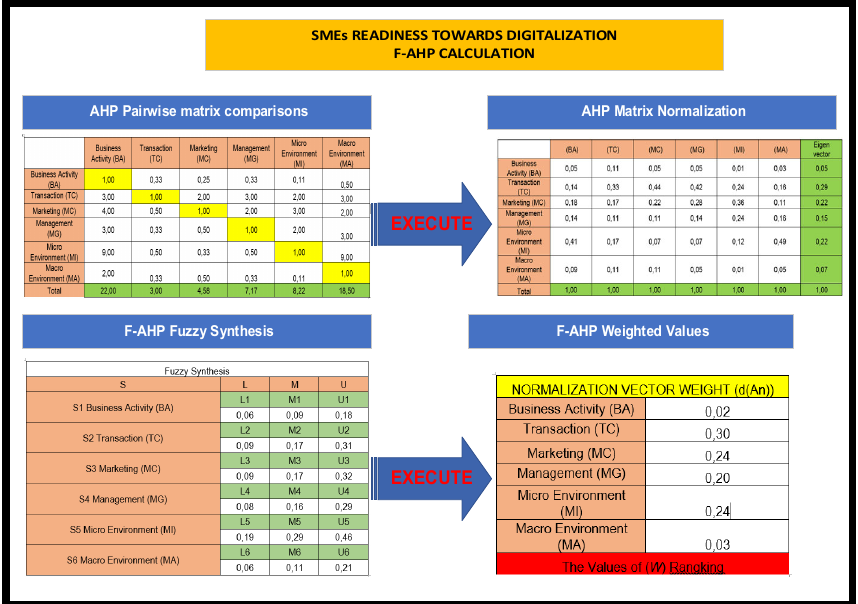
Fig. 7. Interface designed of DSS-SMEsReadiness for F-AHP weighted